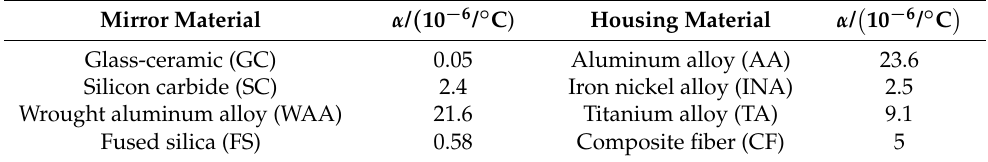
Table 2. Thermal expansion coefficients of common mirror and housing materials.